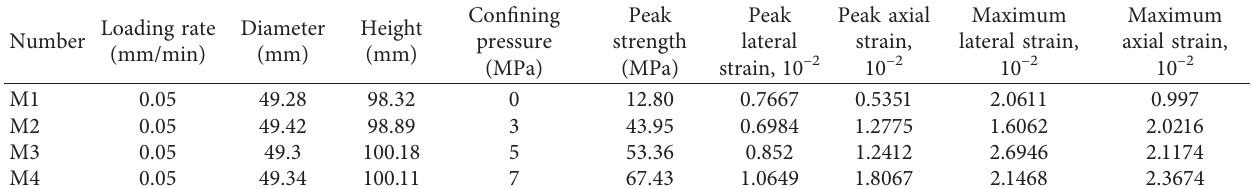
Table 1: Physical and mechanical parameters of coal samples under different confining pressures.